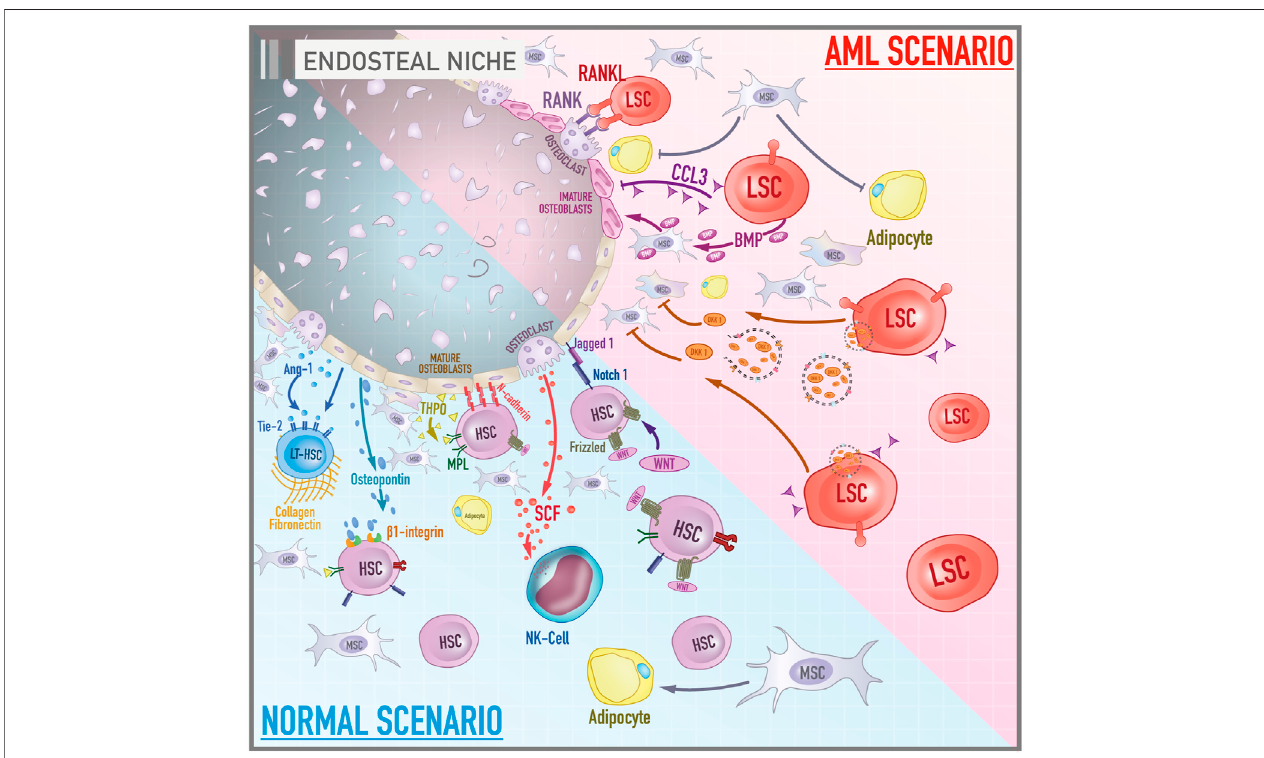
FIGURE1| Cellularandmolecularcomponentsofbonemarrowendostealnicheinbothhealthyandleukemicscenarios.Theillustrationcontraststheactivitiesand components of the endosteal niche under physiological conditions and during the course of acute myeloid leukemia. In a normal scenario, signaling pathways such as MPL/THPO, Jagged 1/Notch 1, and Ang-1/Tie-2 promote the maintenance of hematopoietic cells in a primitive pro fi le and their capacity for self-renewal. Osteopontin, via β 1-integrin, acts as a negative regulator of stem cell pool size by blocking cell proliferation. N-cadherin constitutes a cell adhesion mechanism between HSCs and osteoblasts. In contrast, the role of the canonical Wnt signaling on the maintenance of HSCs is still debated. Collagen and fi bronectin constitute the main components of the extracellular matrix of the bone marrow microenvironment. Mesenchymal stromal cells give rise to osteoblasts and adipocytes. In the AML scenario, leukemic stem cells secrete a variety of molecules such as BMP, DKK1, CCL3 that, together, lead to inhibition of adipogenic differentiation of MSCs, promotion of the osteogenic lineage, impairment of osteoblast functioning and an environment rich in immature osteoblasts. In addition, the RANK/RANKL signaling pathway leads to osteoclastogenesis and increased osteoclast